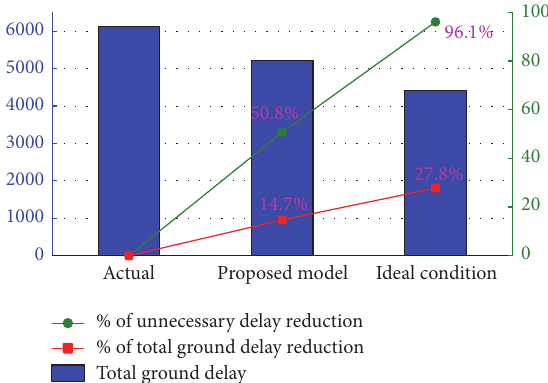
Figure 3: Benefits of the proposed model in terms of delay reduction.